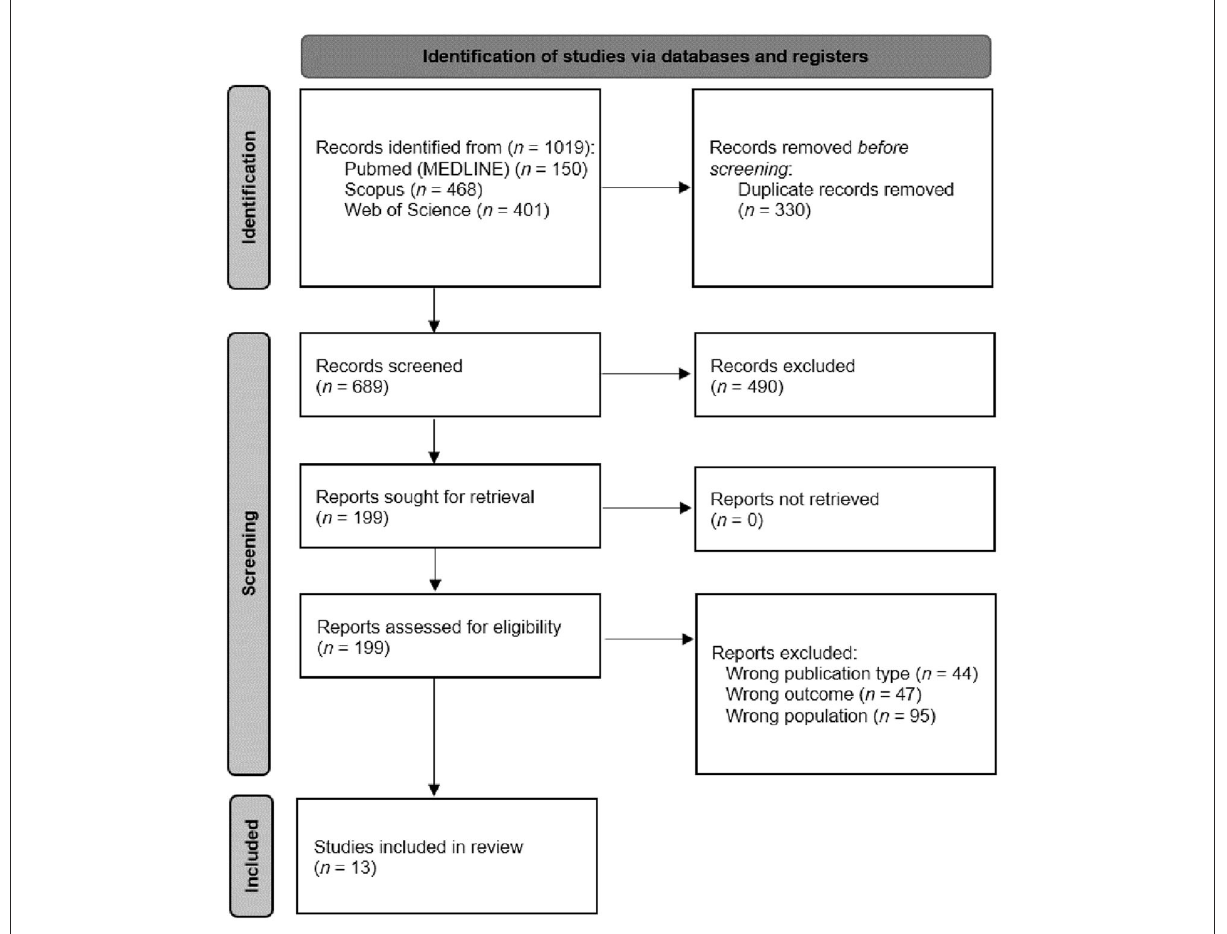
FIGURE1 Flow diagram of the study selection